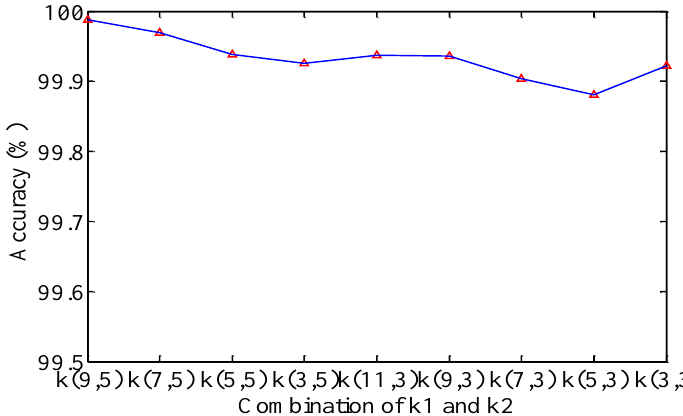
Figure 19. Classification accuracy by different kernel size.